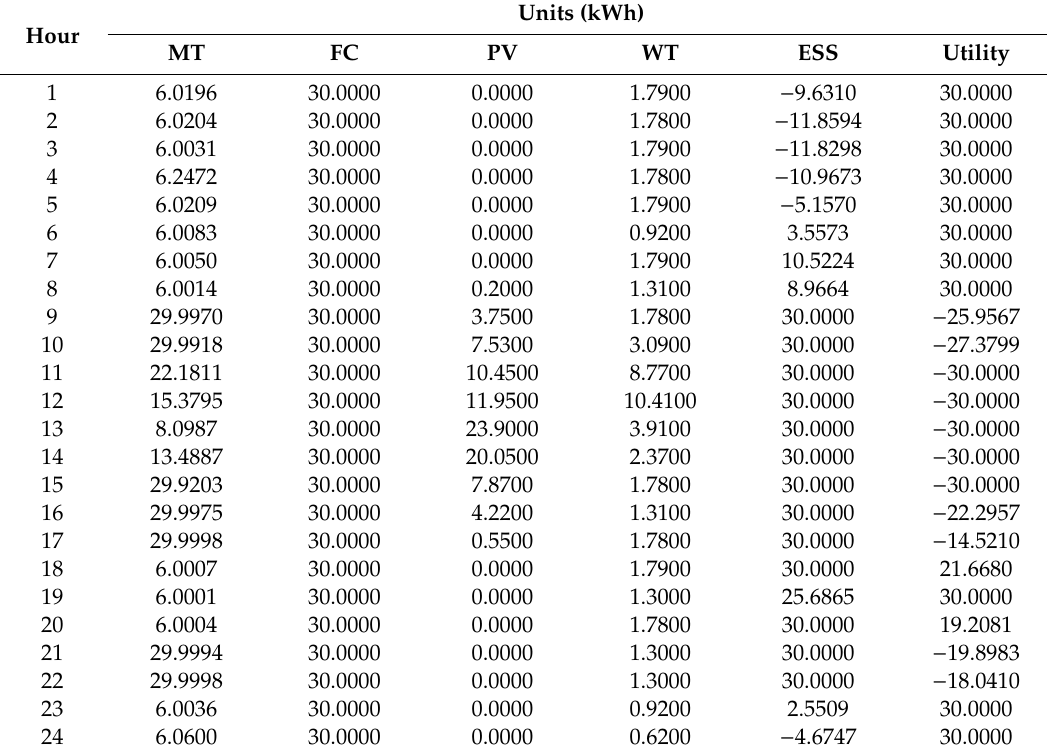
Table 7. Optimal power scheduling ( β = 0.5).